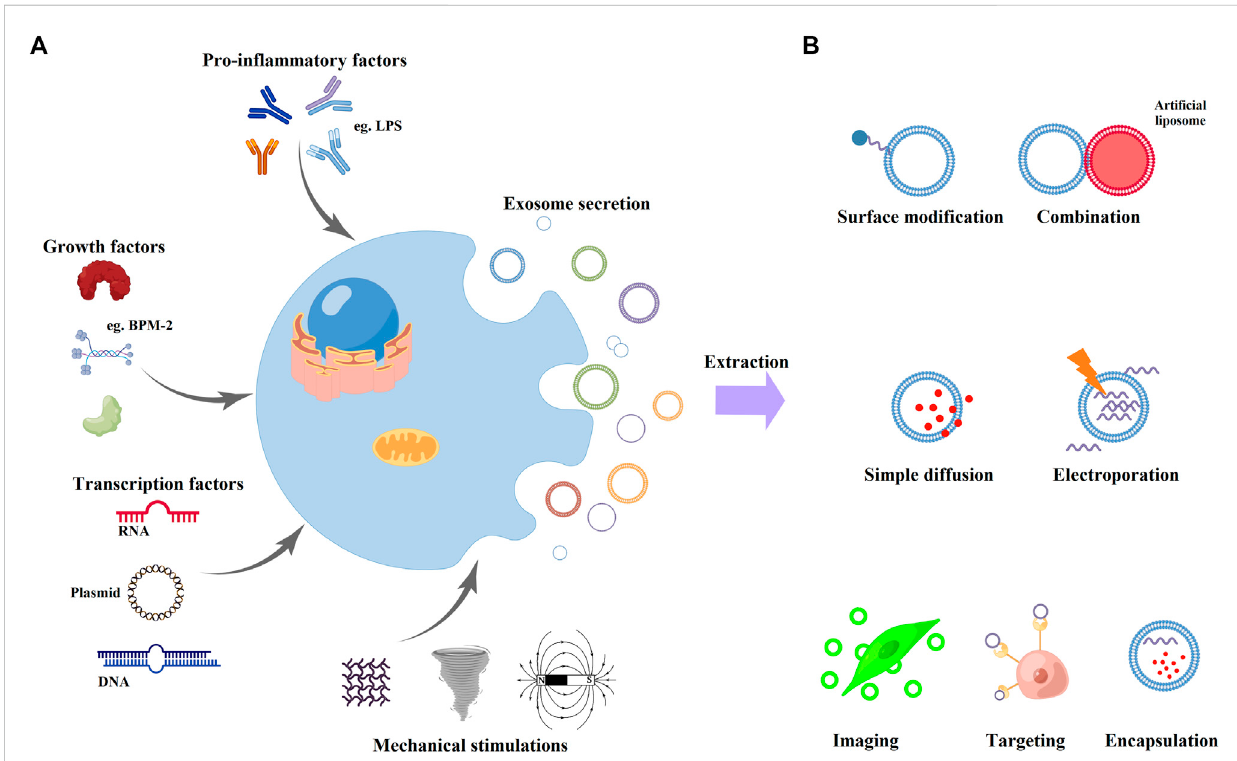
FIGURE 3 Engineering methods to improve exosome properties. (A) Engineering of progenitor cells with various physiological (pro-in fl ammatory factors, growth factors, and transcription factors) or mechanical stimulations (vibration, rotation, and magnetic fi eld). (B) Direct functionalization approaches of exosomes. Researchers could modify the exosome membrane with direct surface modi fi cations and fusion with arti fi cial liposomes. Moreover, exosomes could load other materials by simple diffusion or electroporation. Finally, the functionalized exosomal-based nanomaterials could achieve speci fi c purposes, such as imaging, targeting, and